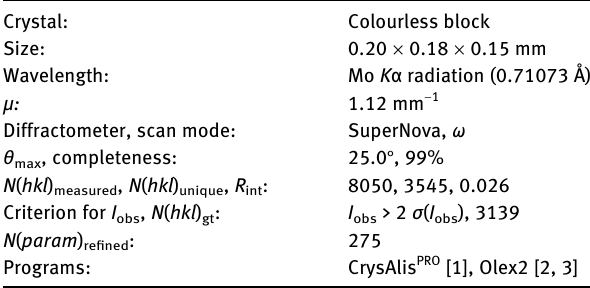
Table  : Data collection and